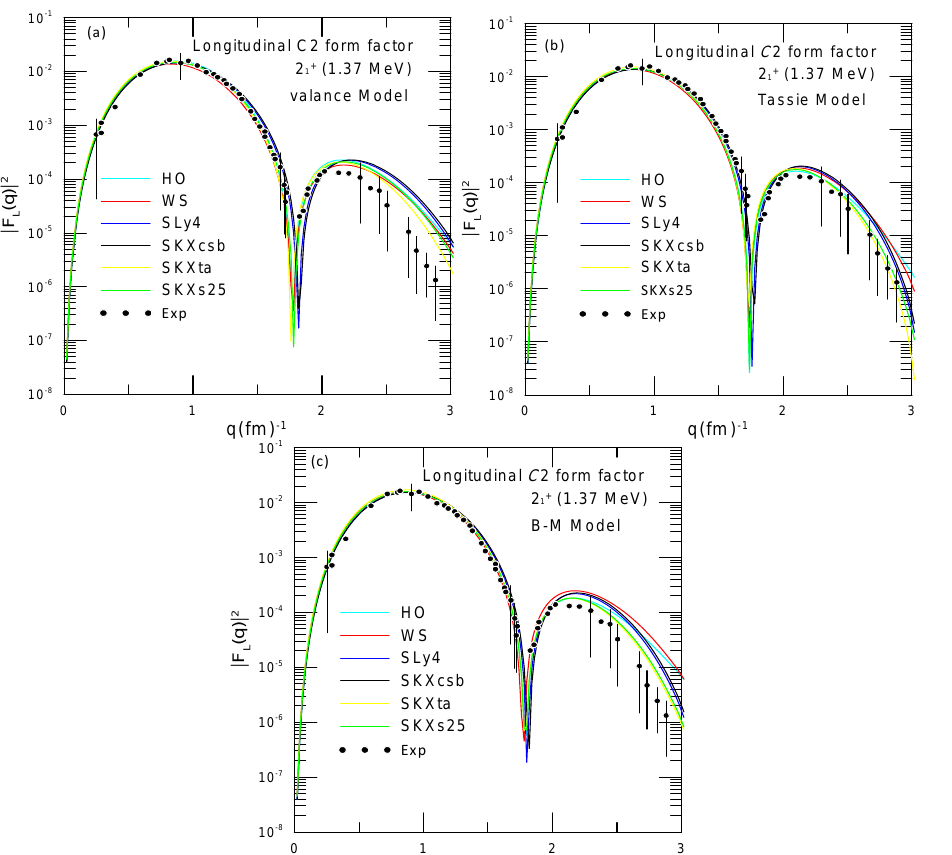
Fig. 2: Theoretical inelastic longitudinal form factors for the first 2 + , 1.37 MeV state using different single particle potential compared with the experimental data taken from Ref.